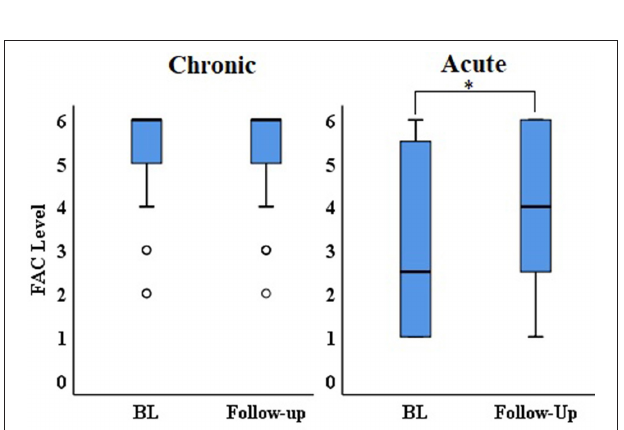
FIGURE 4 | Median and IQR of FAC during baseline (BL) and follow-up for participants in the chronic and acute stage of stroke recovery. * p < 0.05.